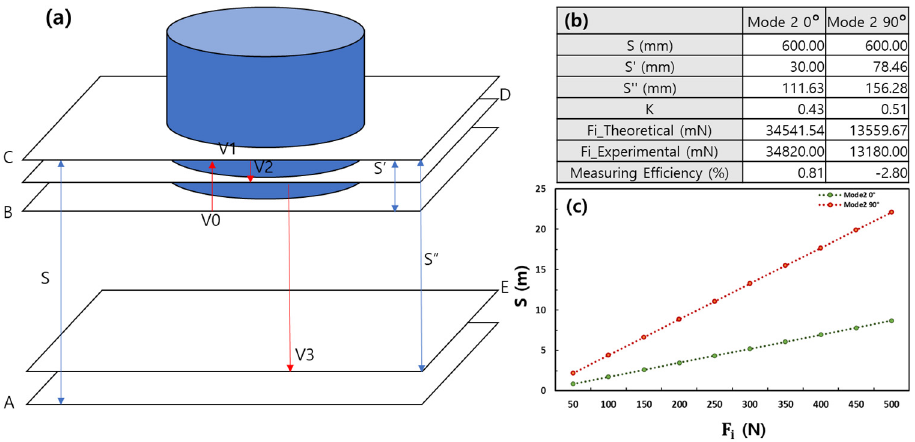
Figure 4. ( a ) Mathematical modeling of shock absorption on impact. The chronological positions of the acrylic plates are denoted by A–E. The structure is the blue cylinder. The structure itself falls, but we assume in this model that the acrylic plate moves up to the structure. V 0 : velocity at which the structure first hits the acrylic plate, V 1 : velocity at which the structure is maximally crushed and completely stops after hitting the plate, V 2 : velocity at which the structure falls off the acrylic plate after completely stopping on the plate, V 3 : velocity at which the structure bounces up and completely stops in the air, S : height from which the structure is dropped, S (cid:48) : maximum extent of structure crushing, and S ”: maximum height from which the structure bounces after hitting the plate. ( b ) Theoretical and experimental impact forces. ( c ) Theoretical impact force F i – S graph/ S , S (cid:48) , S ”, and K are equal to the value at ( b